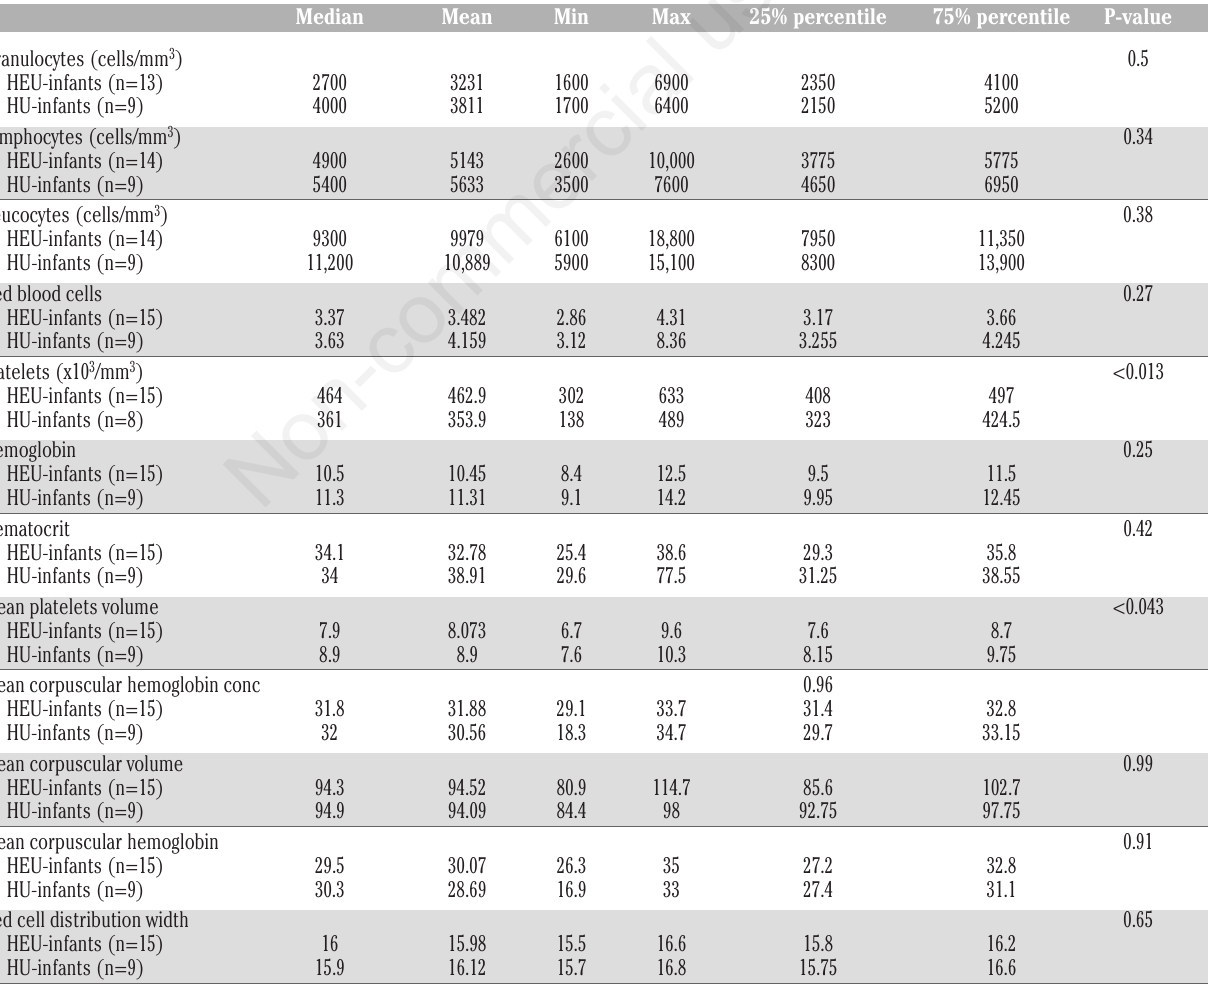
Table 2. Median, mean and ranges of hematological parameters measured in HIV-exposed and unexposed infants. Median